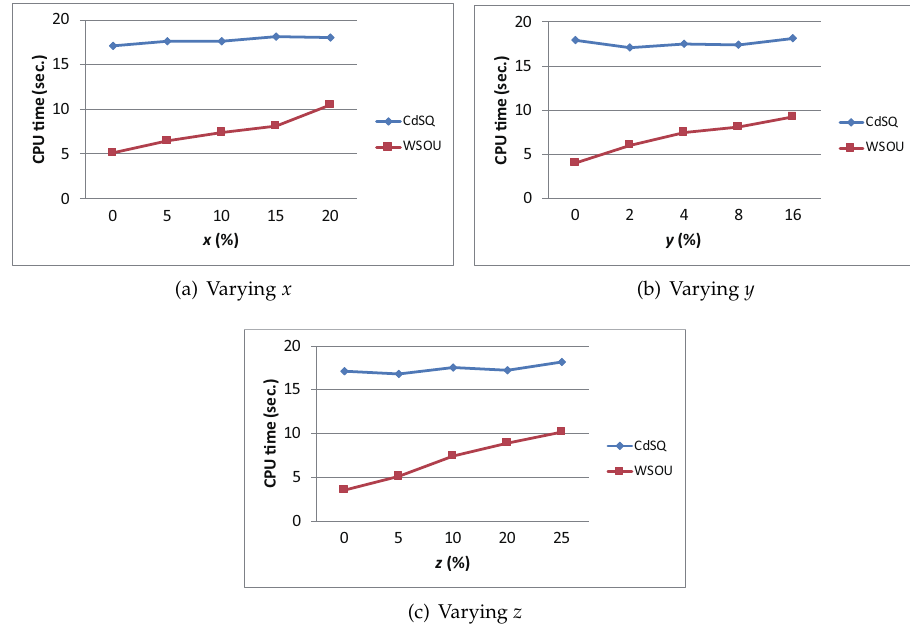
Figure 7. Effect of time-varying